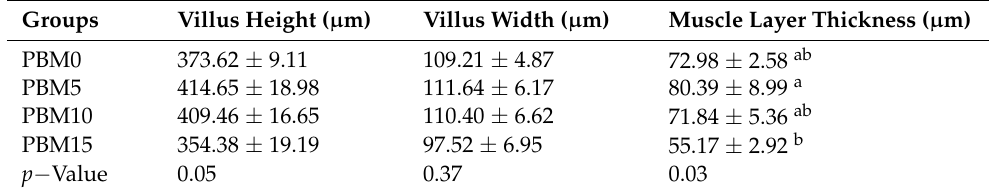
Table 3. Effects of dietary replacement of fish meal with poultry by-product meal on the intestinal villus height, villus width, and muscle layer thickness of Chinese soft-shelled turtle.